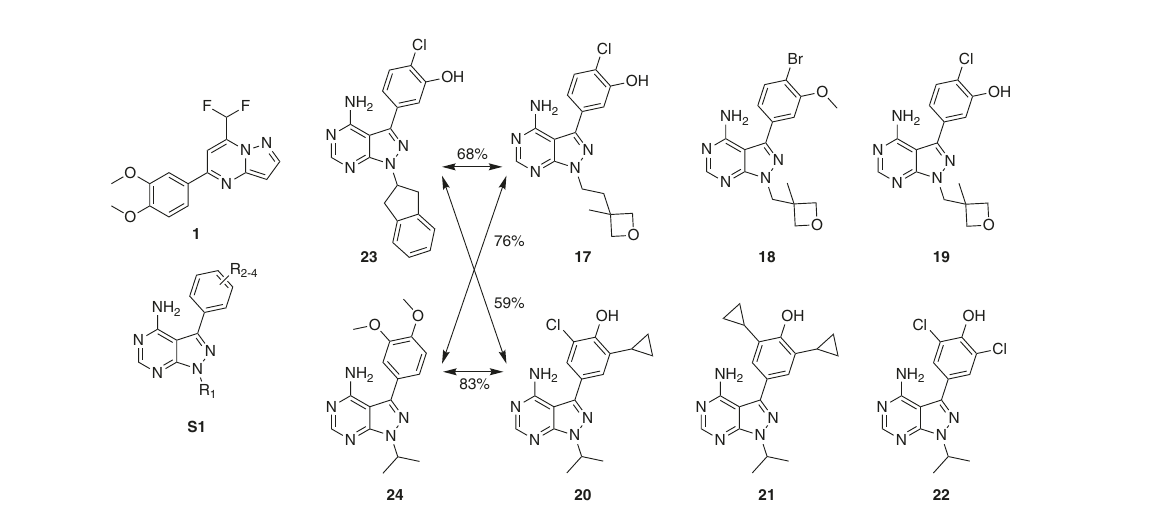
computer-generated molecules 17 and 20 to the known PI3K inhibitors 23 and 24 . Compounds 18 , 19 and 21 , 22 are analogs of molecules 17 and 20 , respectively.